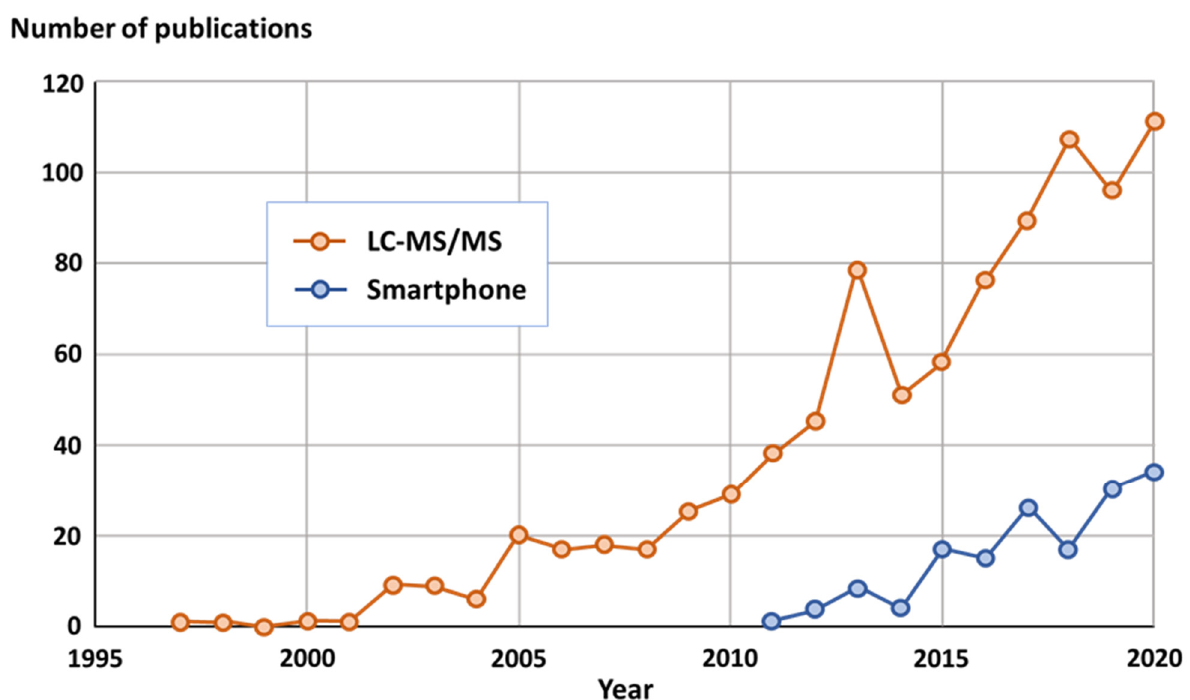
Figure 6. Yearly-based number of publications returned with keywords ‘Food’ and ‘Safety’ in combination with either ‘Smartphone’ or ‘LC-MS/MS’ (LC-MS/MS stands for liquid chromatography-tandem mass spectrometry) on the literature search platform Scopus (www.scopus.com accessed on 15 October 2021).